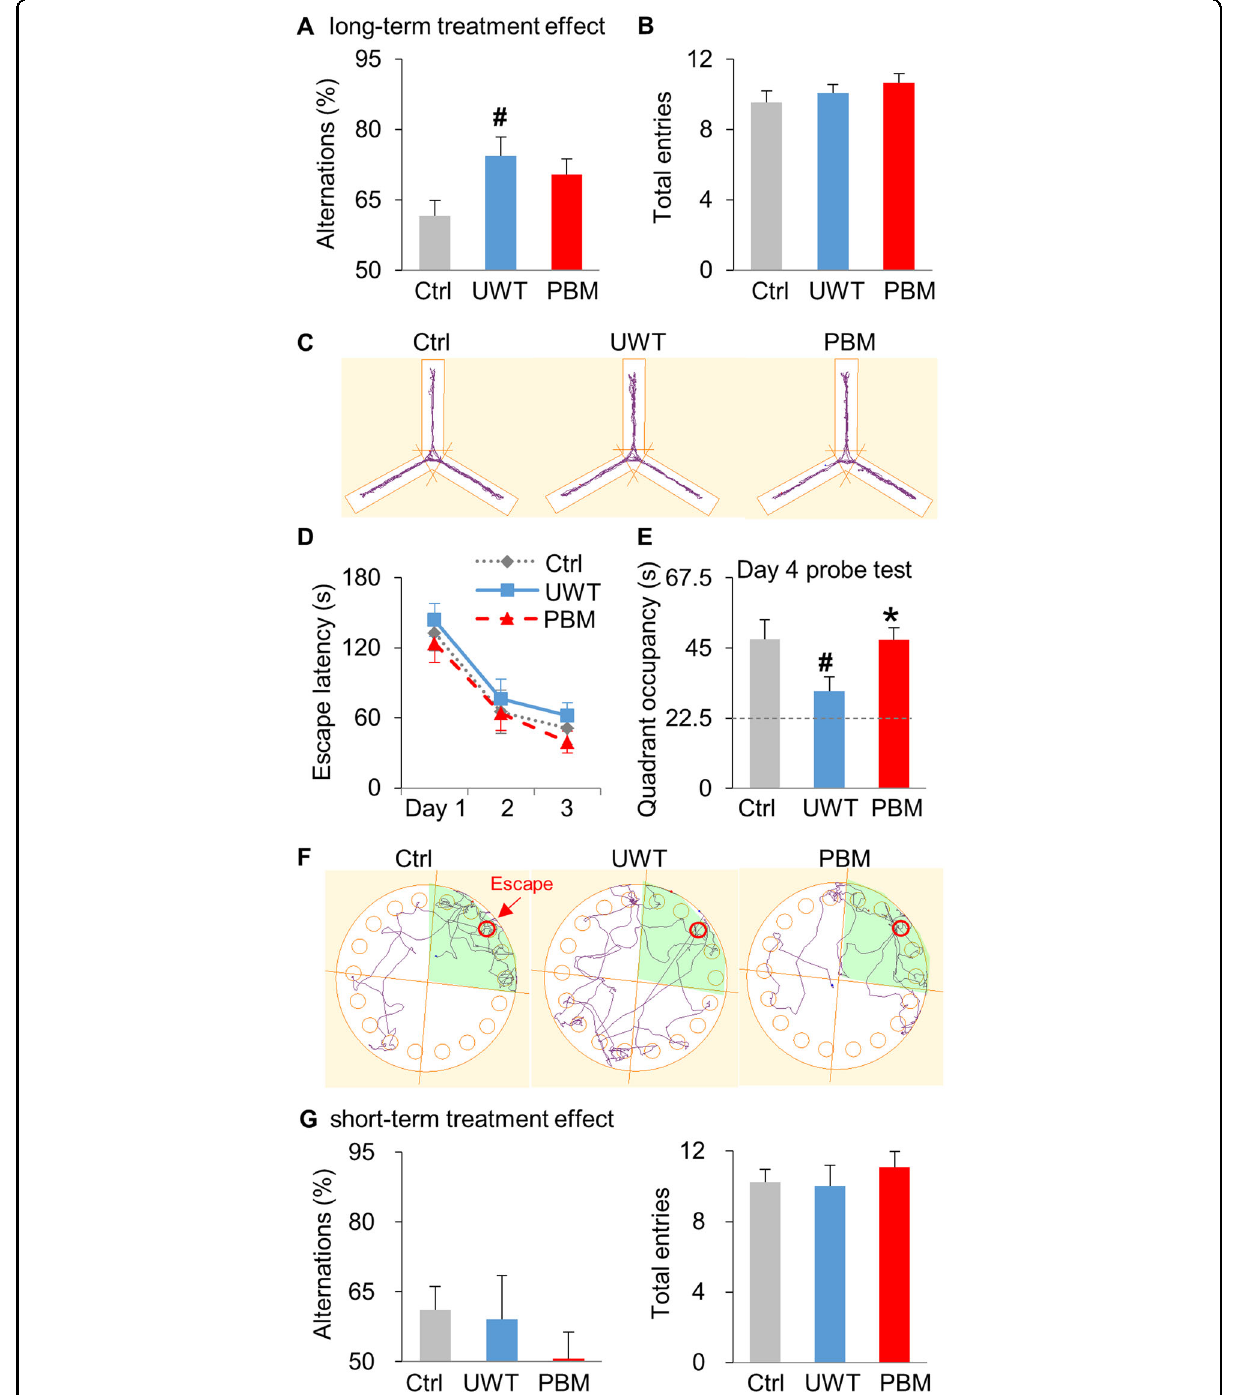
Fig. 3 Cognitive dysfunction was prevented by PBM early interventions. A – C UWT enhances working memory in the Y maze test, and PBM has no treatment effect. A Compared with the ctrl-group, UWT-group displayed better working memory, as shown by a higher percentage of alternation. B As a behavioral measurement control, all three groups had a similar number of total entries. C The apparatus and the representative exploration tracks for each group during Y maze testing. D – F PBM prevents long-term memory impairment in the Barnes maze test. D All three groups exhibited the same learning curve during the three days of training sessions (one trial/ day). E During the probe test session (90s duration) at day 4, rats in UWT-group exhibited signi fi cantly decreased preference (22.5s is random chance as labeled with dash line) for exploring the target quadrant where the escape chamber was previously located, compared with the other two groups. F The apparatus and the representative tracks on the probe test (day 4) for all three groups. Target quadrant is shaded, and the red circle denotes the location for the escape chamber. n = 10, 9, 9 for ctrl, UWT, PBM-group, respectively. G A single dose of PBM treatment has no short-term treatment effect on Y maze testing. n = 8 each for ctrl, UWT, or PBM-group. * P <0.05 versus UWT-group; # P <0.05 versus